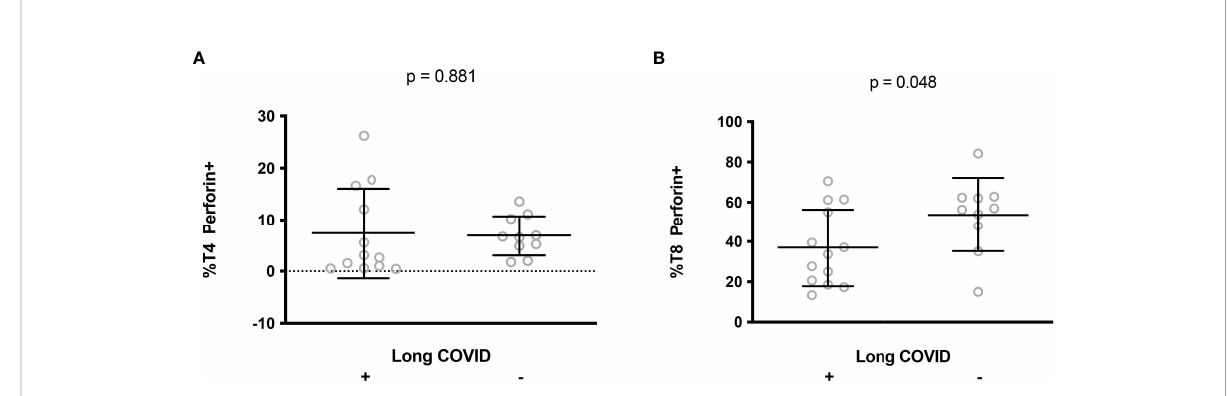
FIGURE 5 Perforin expression in CD4+ (A) and CD8+ (B) lymphocytes during the acute phase of infection in patients who later developed long COVID or